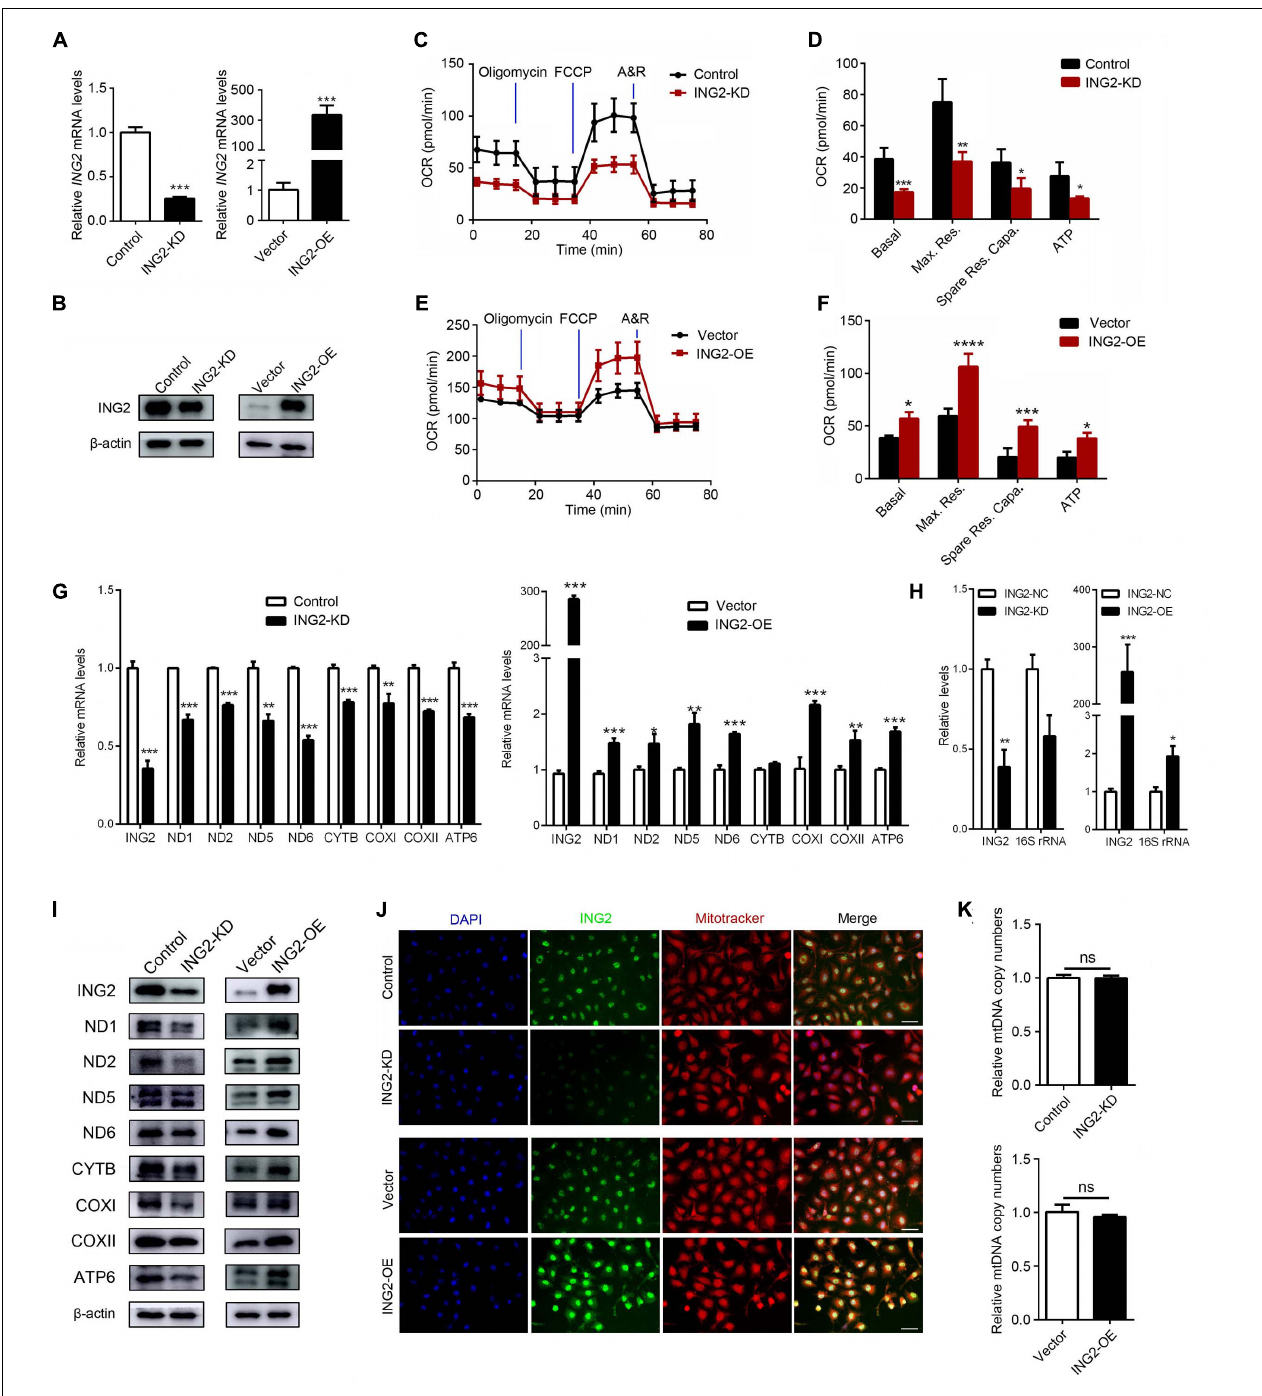
FIGURE 1 | ING2 positively regulates mitochondrial respiration in tubular epithelial cells. HK2 cells were transfected with ING2-shRNA or ING2-overexpression plasmid. (A,B) The transfection efficiencies were evaluated by qPCR and Western blotting, respectively. (C–F) Following transfection, mitochondrial OXPHOS of HK2 cells were detected using Seahorse. OCR, oxygen consumption rate; FCCP, carbonyl cyanide 4-(trifluoromethoxy)phenylhydrazone; A&R, antimycin and rotenone. (G,H) mtDNA-encoded components for complex I, III, IV, and V and 16S rRNA were determined by qPCR. (I) mtDNA-encoded components for complex I, III, IV, and V were determined by Western blotting. (J) The mitochondria were stained with MitoTracker (red) and ING2 (green) followed by DAPI (blue) re-dyeing. (K) The mitochondria DNA (mtDNA) copy number was determined by qPCR with G6PC serving as internal reference. Data were from three individual experiments and presented as mean ± SEM. * p < 0.05; ** p < 0.01; *** p < 0.001; **** p < 0.0001. ns, not significant.